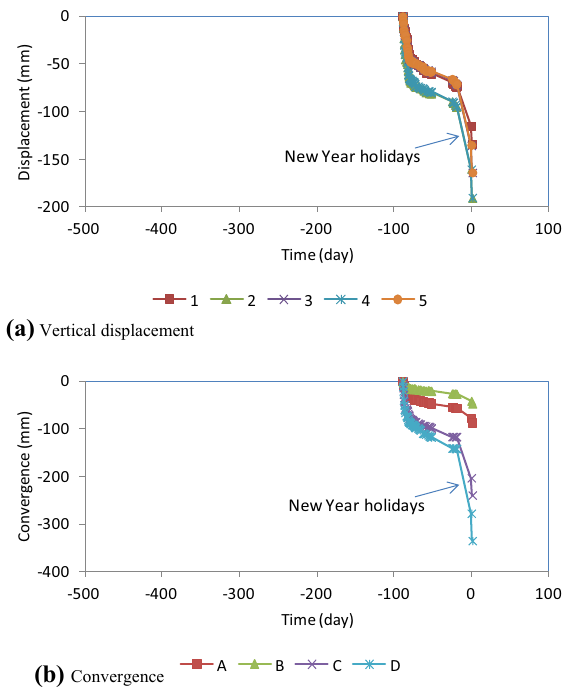
Fig. 4 Monitored deformation at the section A (56.8 m behind the face). Negative values indicate a 17 downward and b contraction. Time is set to zero at the discovery of the damage (Jan. 6,